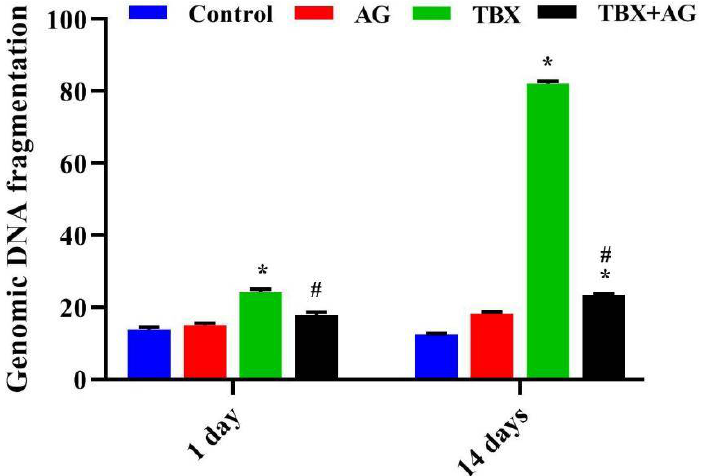
Figure 3. Representative photographs (1.8% ethidium bromide-stained agarose gel) show the pro- tective effect of AG against TBX-induced DNA damage in kidney tissues after 1 and 14 days of treatment. AG: 10% Arabic gum, TBX: Telebrix (1600 mg I/kg b.wt.) and TBX+AG: co-treatment with 1600 mg/kg b.wt. and 10% Arabic gum.